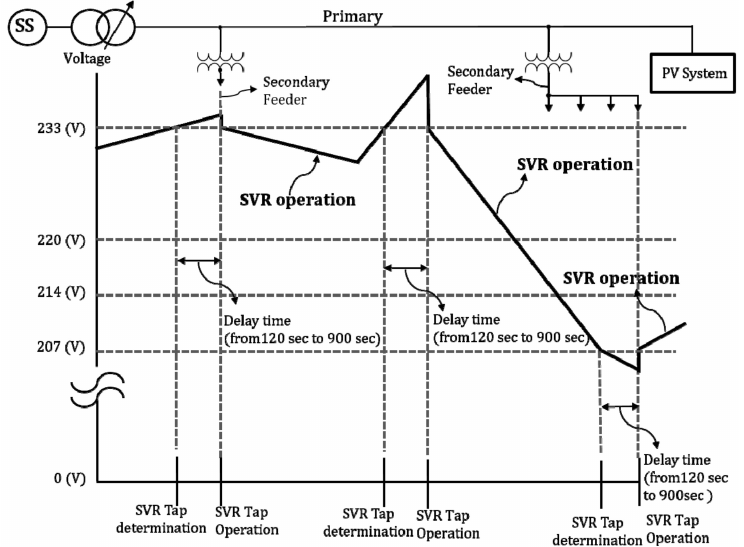
Figure 1. Voltage control in the primary feeder by the step voltage regulator